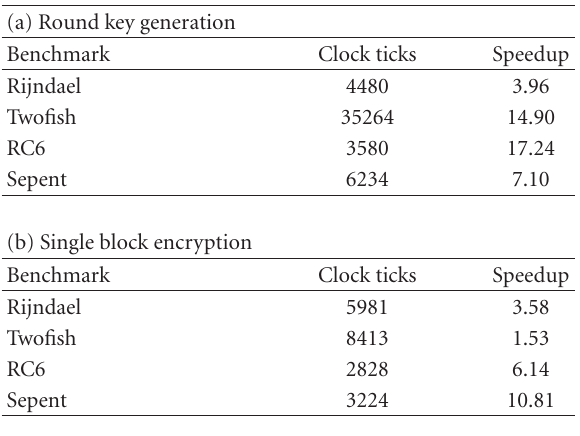
Table 8: E ff ects of dual ported memory access on an 8 operator array with 3 multiplication operators and 1 division